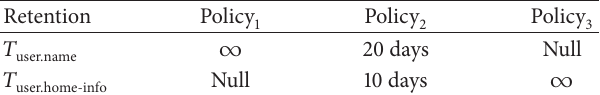
Table 2: Retention values of Data elements in member services.